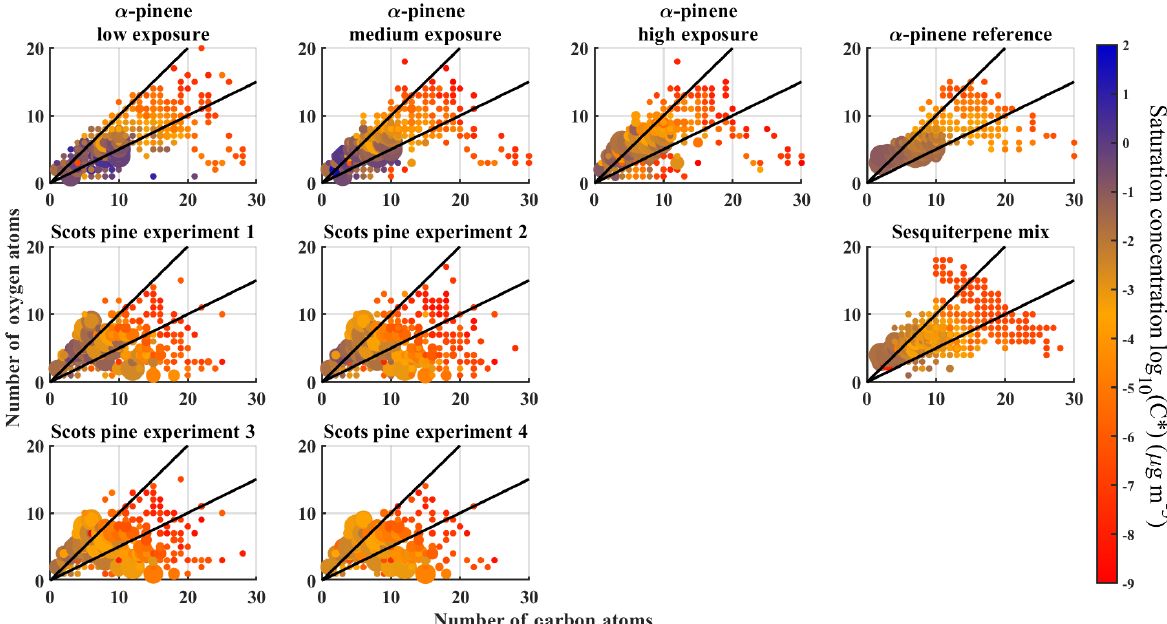
Figure 8. Number of oxygen molecules versus number of carbon molecules for each compound and each experiment. Colours correspond to the saturation ratio C ∗ as derived from the measured T max . The size of a marker corresponds to the signal of the compound. The two black lines in the figures correspond to O : C = 0 . 5 and O : C = 1 ratios, for